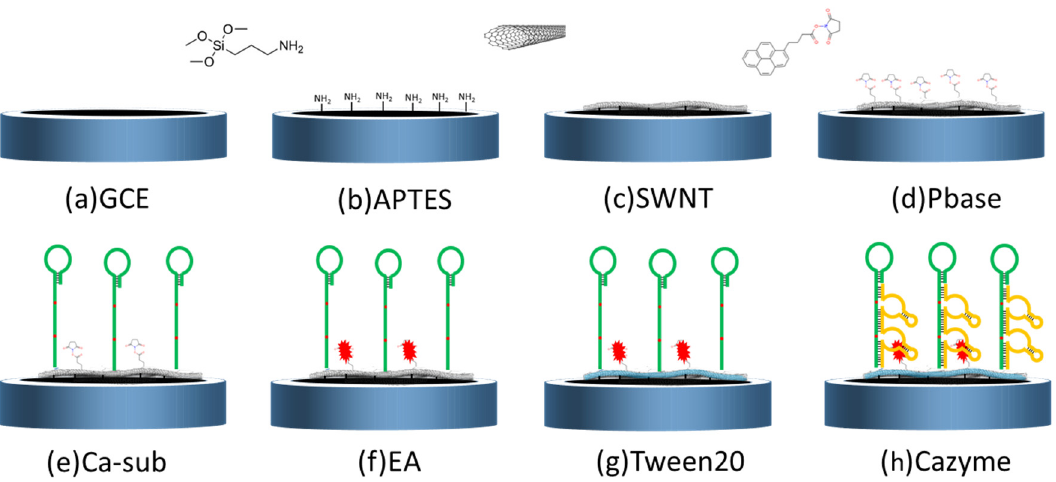
Figure 1. GCE functionalized with APTES, SWNT, Pbase, Ca_sub, EA, Tween20, and Cazyme.